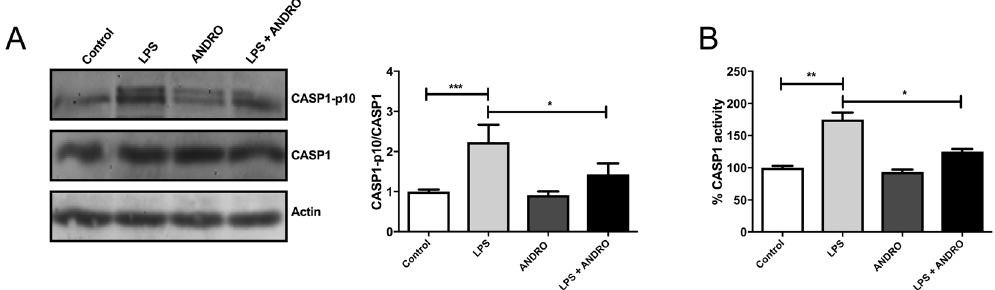
Figure 7. Andrographolide (ANDRO) inhibits Caspase-1 (CASP1) activation and interleukin 1 β (IL1 β ) maturation in vitro . Primary hepatocytes isolated from C57bl6 mice were incubated for 24 h with palmitic acid to induce lipid droplet accumulation. Then, cells were stimulated with Lipopolysaccharides (LPS) (1000 ng/ ml) for 24 h in the presence or absence of ANDRO (50 μ M). (A) Protein levels of CASP1 and cleaved CASP1 (CASP1-p10) were determined by Western blot as described in material and methods. Actin was used as loading control. The CASP1-P10/CASP1 ratio was calculated to assess the generation of active CASP1. (B) CASP-1 activity as evaluated by an enzymatic assay. Statistical significance was evaluated using ANOVA with a post-hoc Bonferroni multiple-comparison test ( * p ≤ 0.05, ** p ≤ 0.01 and *** p ≤